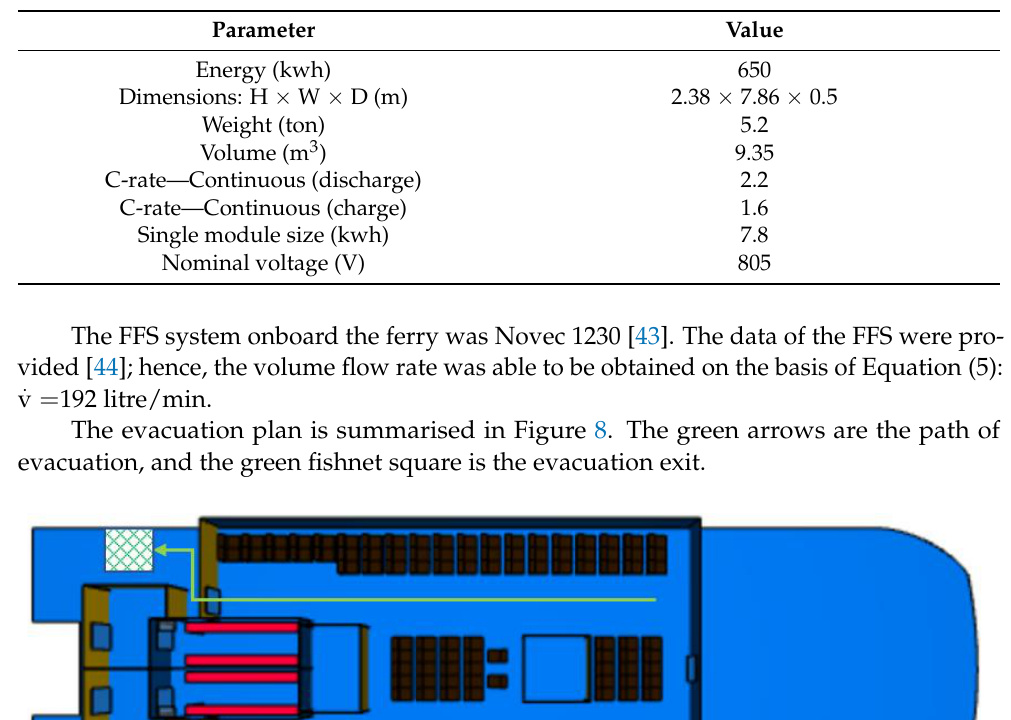
Figure 8. Ferry evacuation plan.